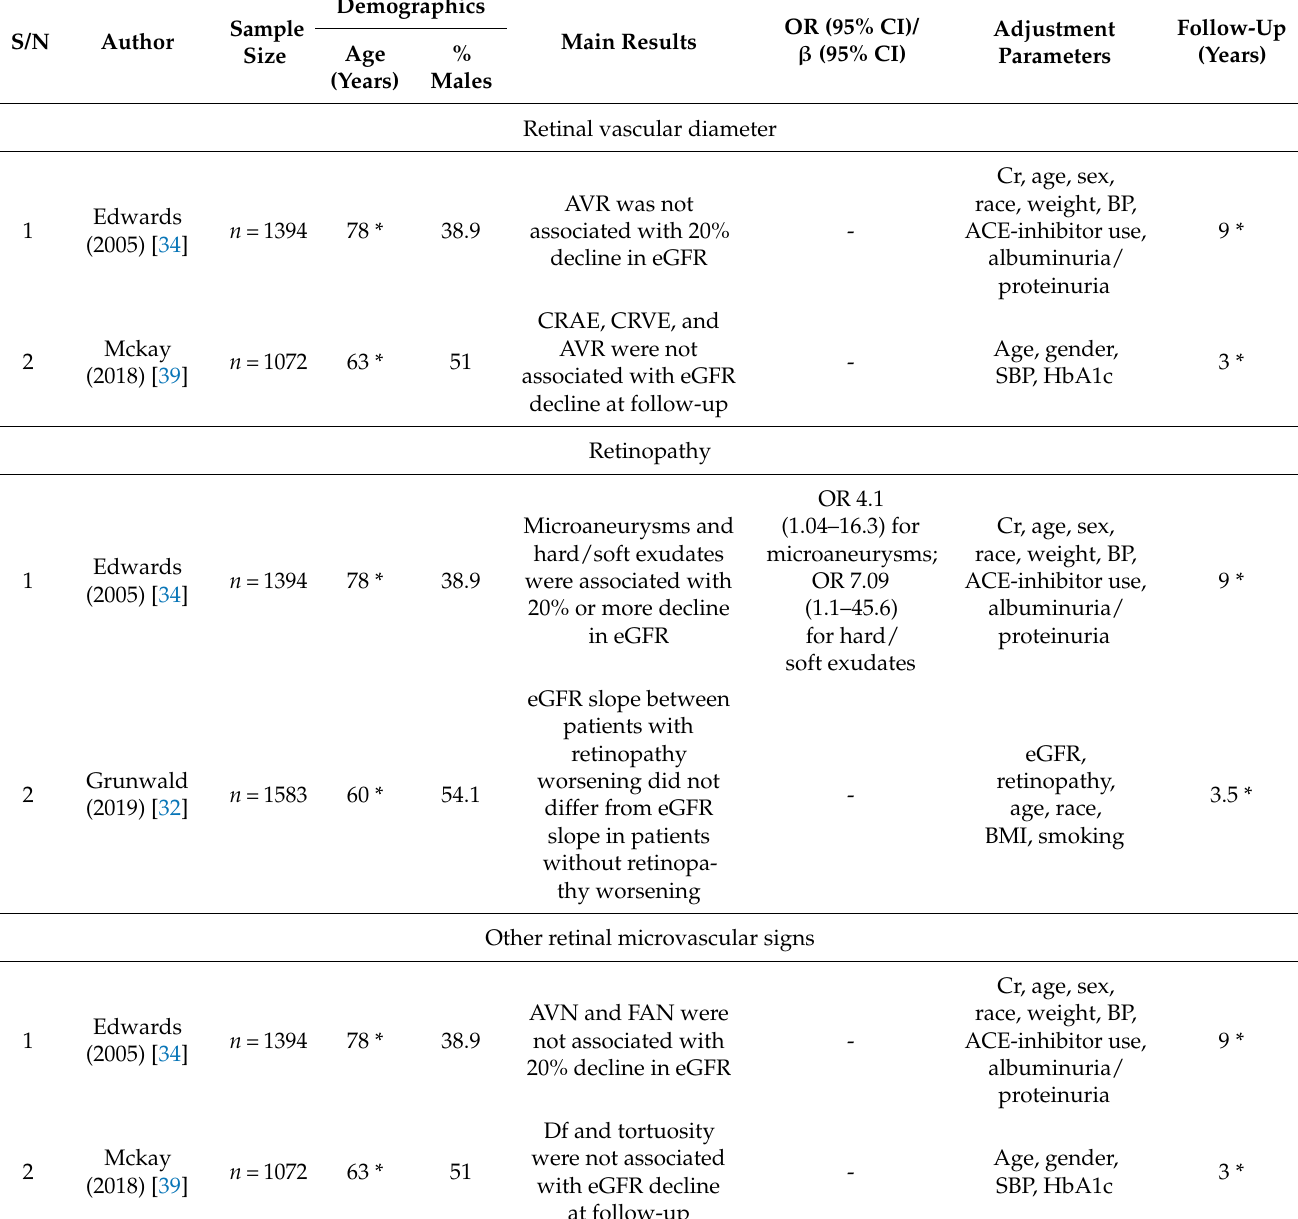
Table 10. Retinal microvascular signs and concurrent eGFR in diabetic